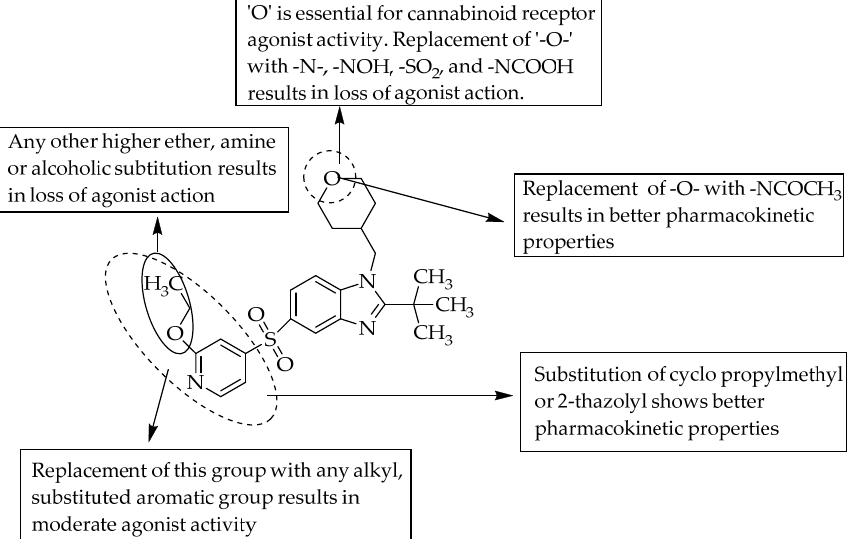
Figure 9. SARs of 2-isbutyl-5-sulfonylbenzimidazole derivatives.